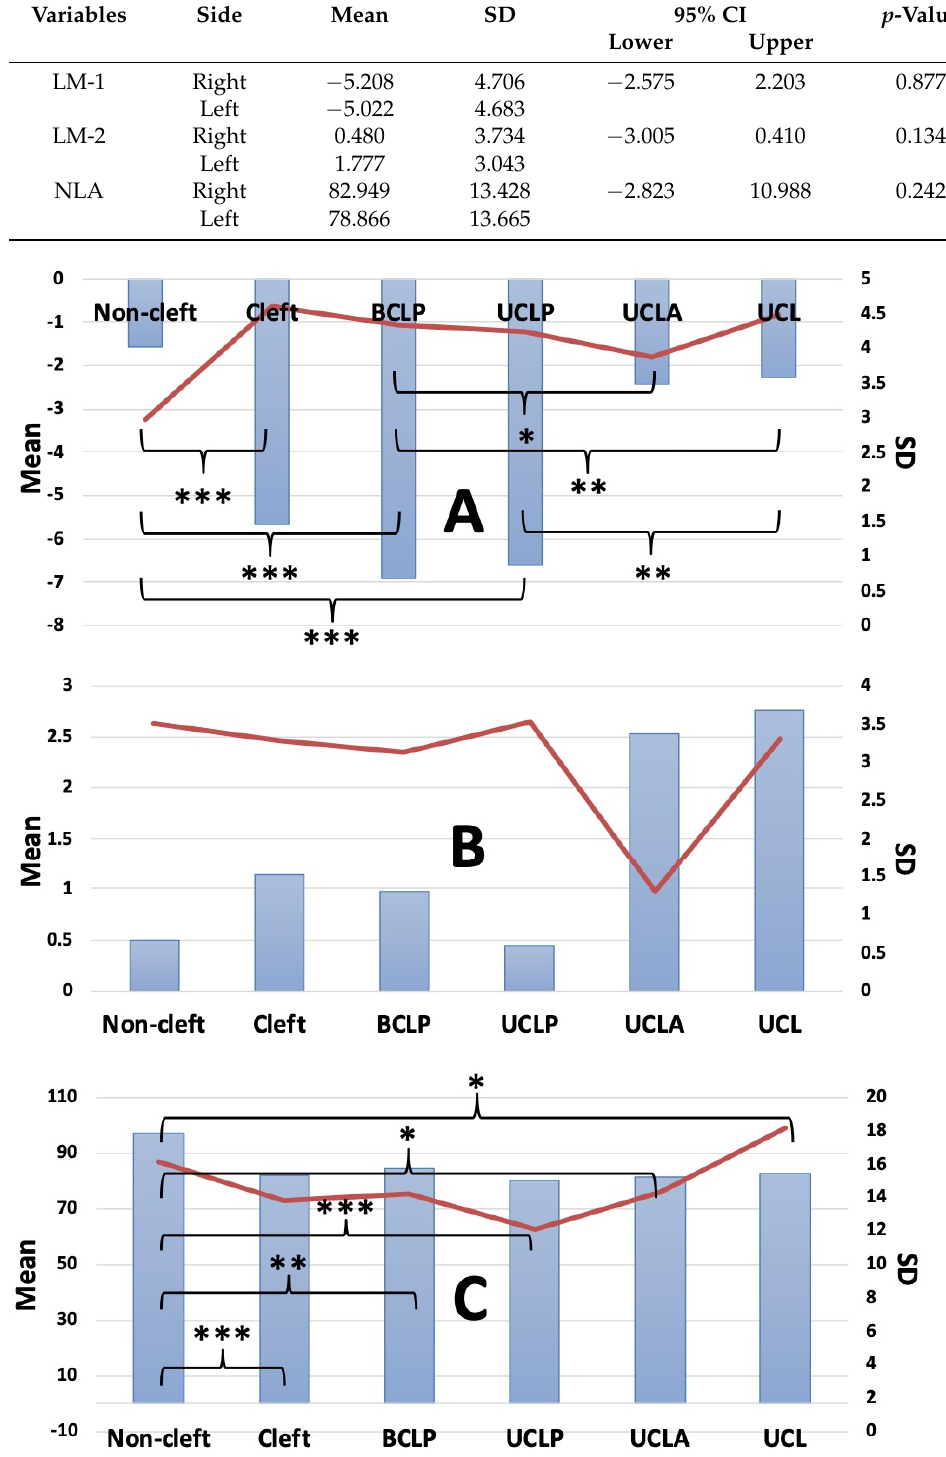
Table 4. Side disparities for Upper lip to E plane (LM-1), Lower lip to E plane (LM-2), and Nasolabial angle (NLA) among non-cleft, unilateral cleft lip and palate (UCLP), unilateral cleft lip and alveolus (UCLA), and unilateral cleft lip (UCL) individuals (N = 63, Right = 27, and Left = 36). Variables